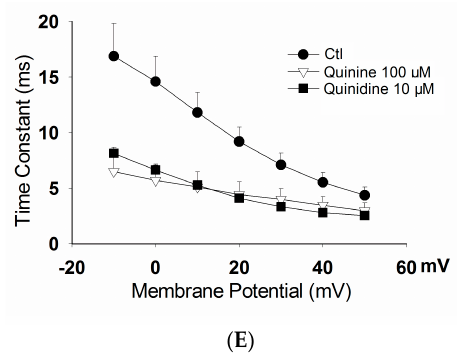
Figure 3. Effects of quinidine and quinine on gating properties of the hERG channel in Xenopus oocytes. ( A ) Quinidine and quinine block open channels. The currents were elicited from a holding potential of − 80 mV to a depolarizing potential of +20 mV for 1.4 s; ( B ) Protocol and representative currents of deactivation; ( C ) The mean time constants of deactivation before and after drug treatments. Quinidine slowed deactivation whereas quinine accelerated deactivation. * p < 0.05, n = 10; ( D ) Representative current tracing for inactivation using a three-pulse protocol; ( E ) The time constant for onset of inactivation before and after exposure to 10 μ M quinidine or 100 μ M quinine. Both quinidine and quinine accelerated the channel inactivation. Abbreviation: ctl, control.